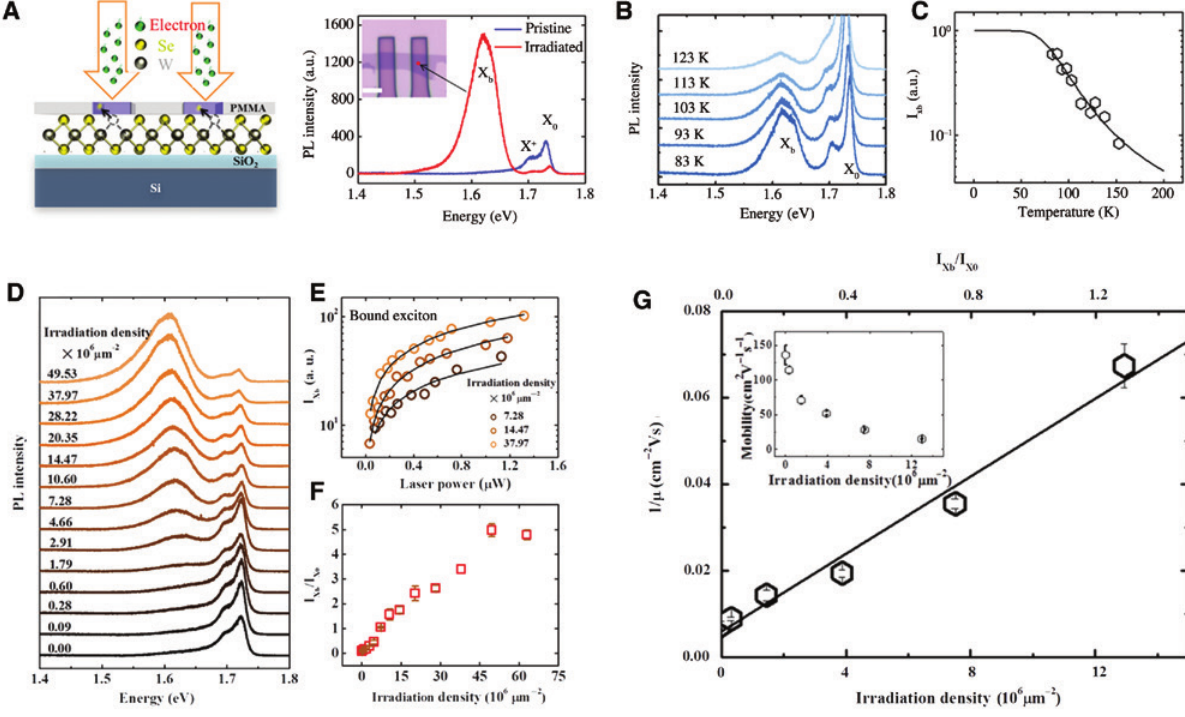
sample during the EBL process. (Right) PL spectrum 2 intensity (C) of WSe after electron-beam irradiation. (D) PL spectra of mon- b 2 under different irradiation density. (F) The b